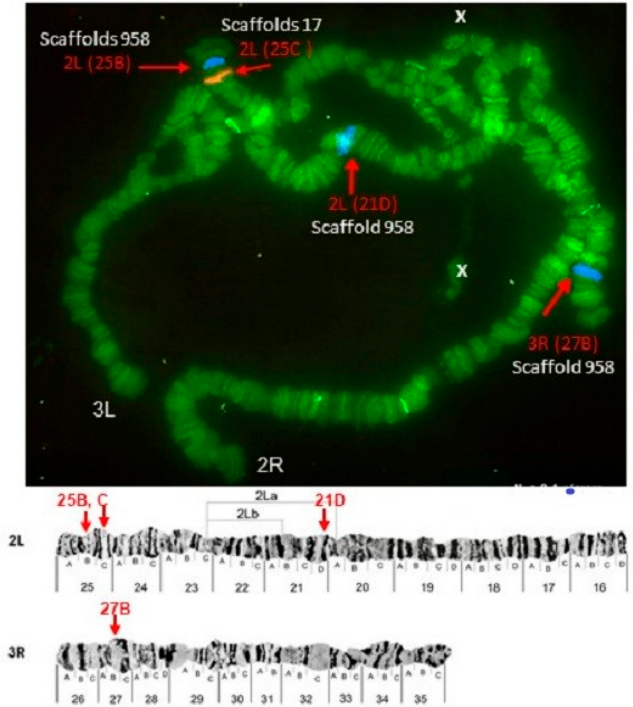
Figure 5. Pb19r-Cy 3 probe, mapped in 2L (25C) and Pb20b-Cy 5 probe mapped in 2L (21D and 25B) and 3R (27B). Chromosomal bands with positive hybridization are identified with text in red, and the corresponding scaffolds in An. darlingi genome assembly AdarC3 are indicated in white text.